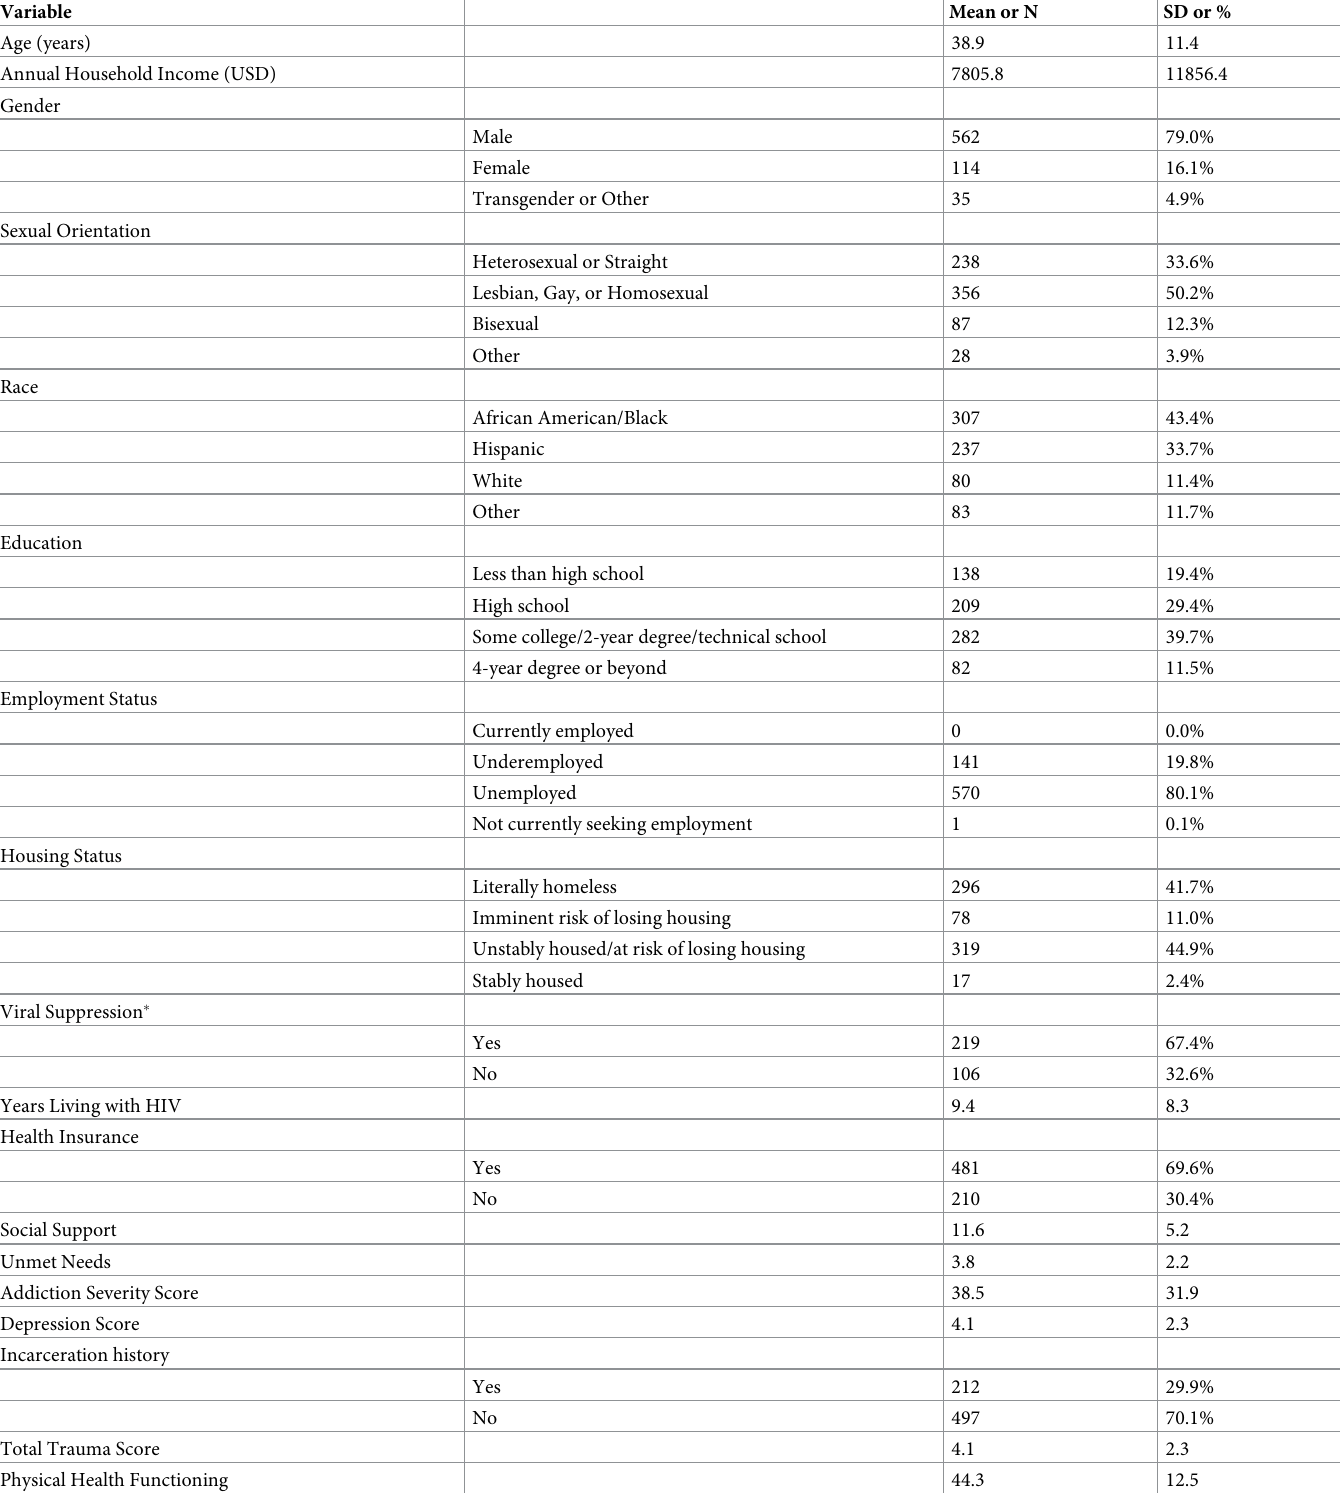
Table 1. Demographic and other study variables (N =